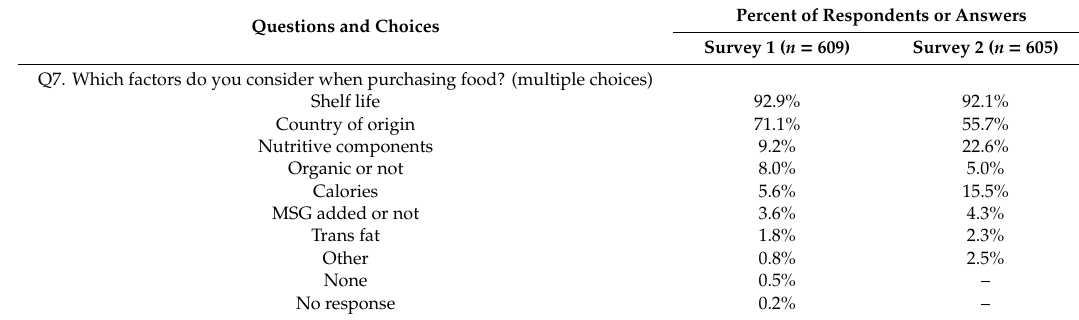
Table 4. Consumers’ interest in major factors a ff ecting food